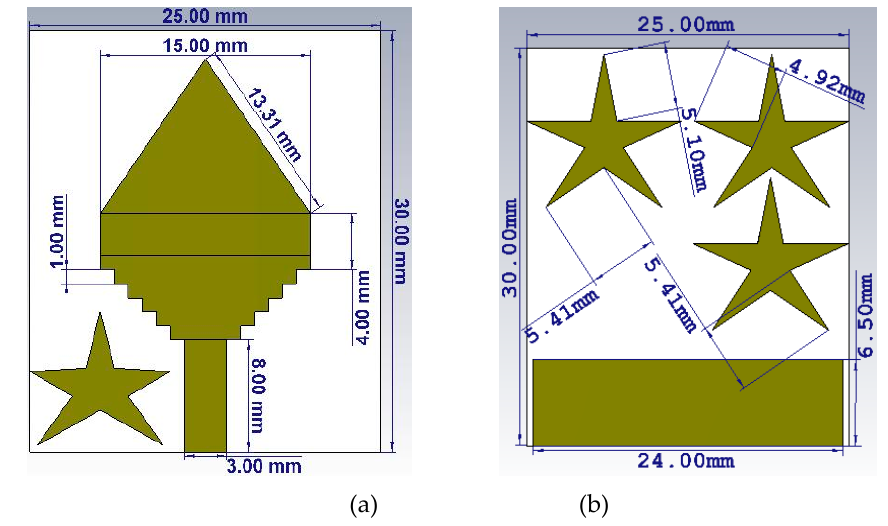
Figure 1. Geometric structure of the realized antenna: ( a ) front view and ( b ) back view.